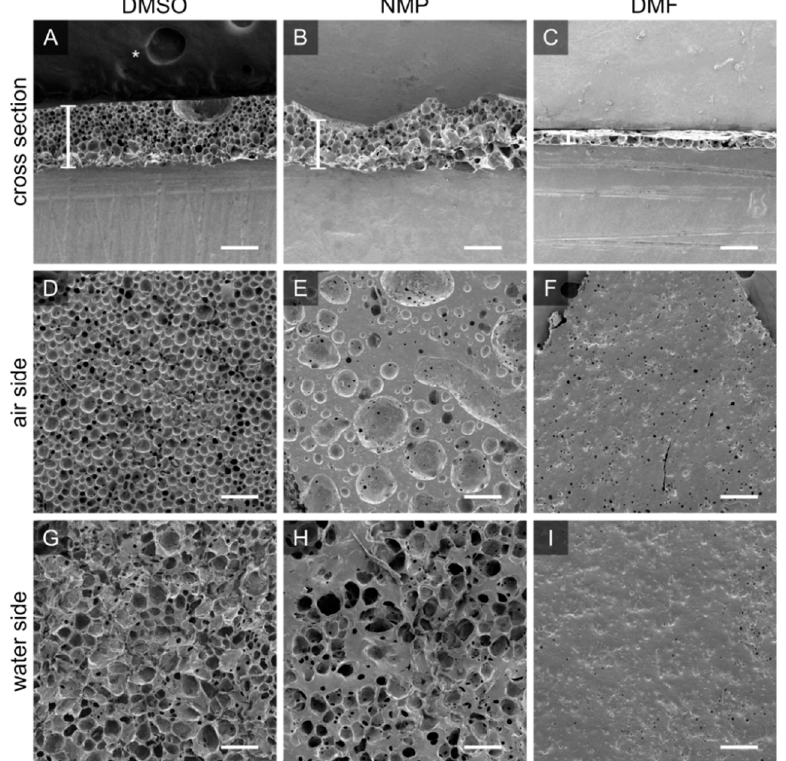
Figure 3. PTMC-dMA dissolved in DMSO, NMP and DMF results in different porous scaffolds. Scanning electron micrographs for PTMC-dMA scaffolds with an initial concentration of 25% ( w / w ) in DMSO (scaffold Sc1), NMP and DMF prepared by air–water interfacial phase separation for 10 min. The top panels ( A – C ) show the cross sections of the scaffolds, with the air side facing upwards. Scaffold thickness is indicated by a white vertical bar. The middle panels ( D – F ) show the air side, and the bottom panels ( G – I ) show the water side of the scaffolds. Scale bar is 200 μ m. The asterisk (*) indicates the carbon tape that was used to stick the samples to the SEM stub.